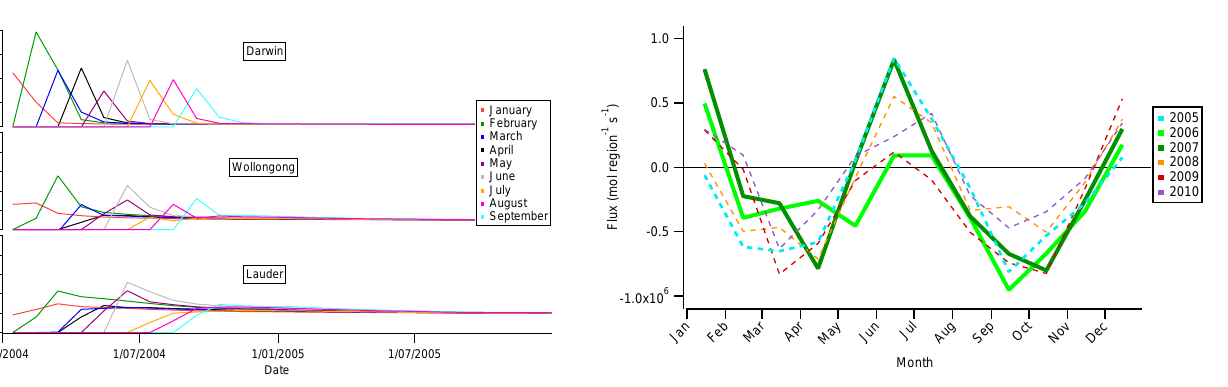
Figure 13. The optimized tropical Australian terrestrial biosphere changes resulting from Figure 12. The time series of relative X CO 2 fluxes for each year from 2005 to each month’s terrestrial biosphere flux in the tropical Australian values are normalized to the long-term value region. The X CO 2 caused by the pulse in question and therefore are always positive, and indicate the relative ability of a flux from a particular month to affect the X CO . The effect of each month’s terrestrial biosphere 2 flux reaches a maximum X CO contribution of 1.5µmolmol − 1 at 2 Darwin with a long-term effect of less than 0.1µmolmol − 1 at all sites.